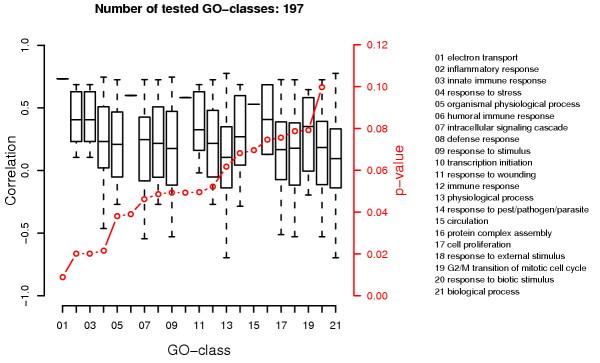
Correlations and p-values of the expression dataset from Higgins. Analogous to figure 3